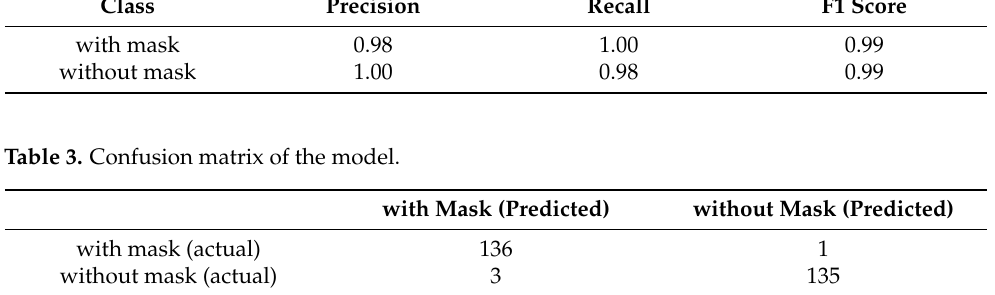
Figure 32. Accuracy of mask wearing detection. Table 2. Performance of the model.